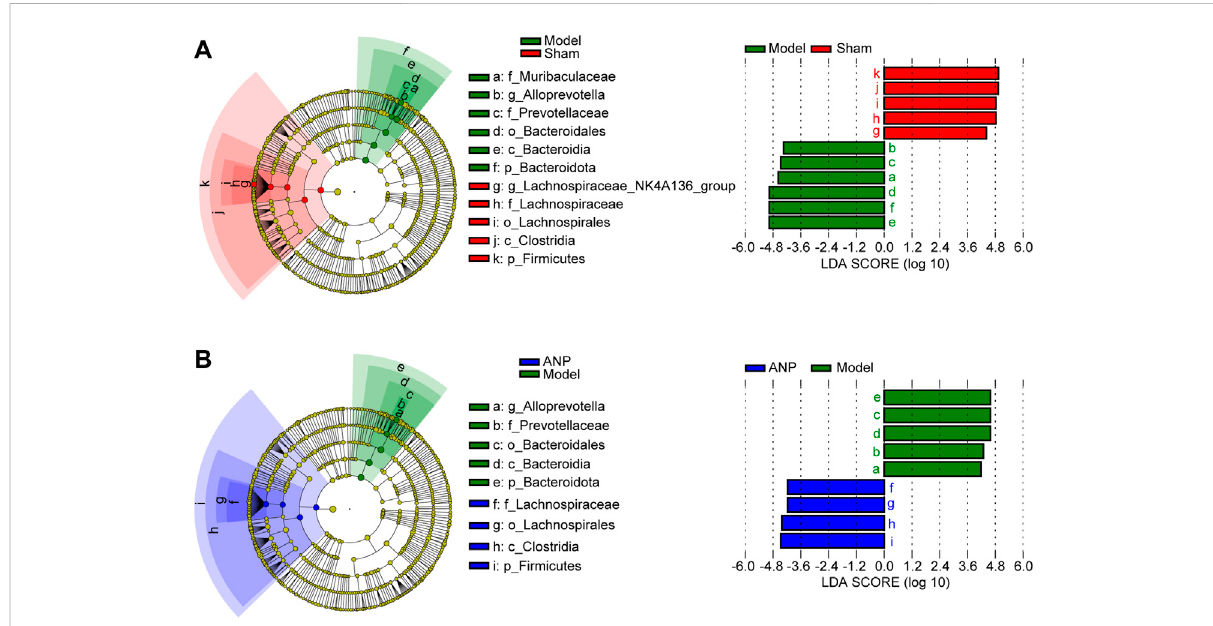
FIGURE 5 LEfSe analysis for the gut microbiota alterations among thegroups. (A) LEfSe analysis between themodel group and the sham group. The inner to outer rings represent phylum, class, order, family, and genus. (B) LEfSe analysis between the ANP group and the model